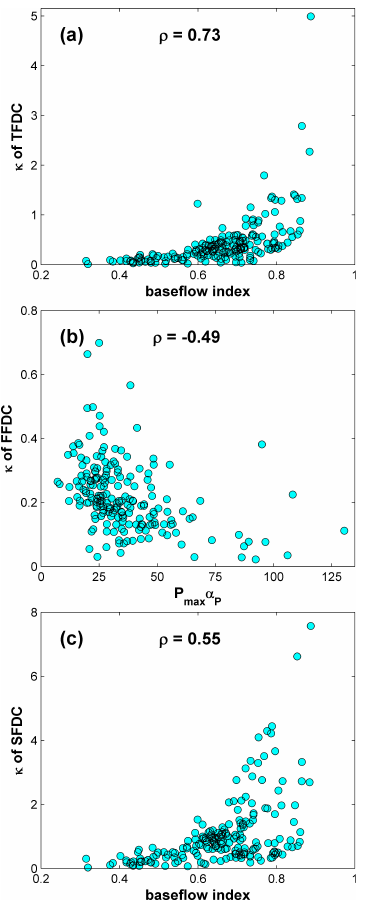
Fig. 9. Correlation of parameter κ of annual TFDC (ATFDC), an- nual FFDC (AFFDC) and annual SFDC (ASFDC) of 8 selected catchments (inter-annual variability) with catchment physical char-